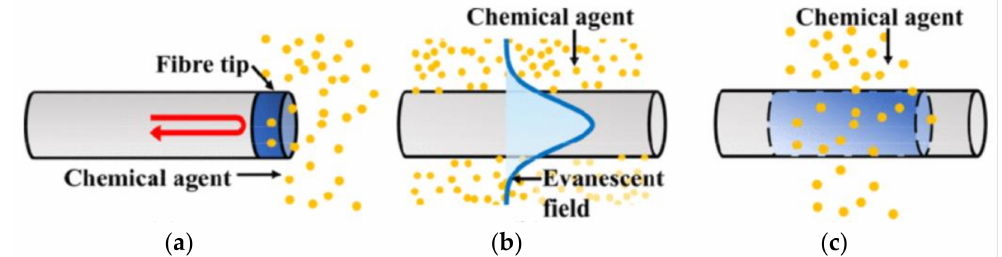
Figure 5. Basic sensing schemes for typical fiber-optic chemical sensors based on ( a ) fiber tip, ( b ) evanescent field sensing, and ( c ) simple transmission setup. (Reprinted from [34] under Open Ac- cess conditions).